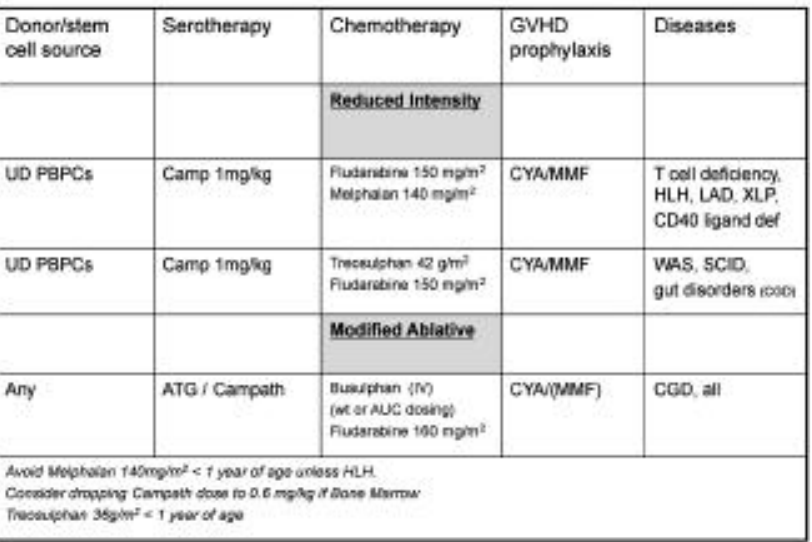
Tabella 3. Novel IE EBMT